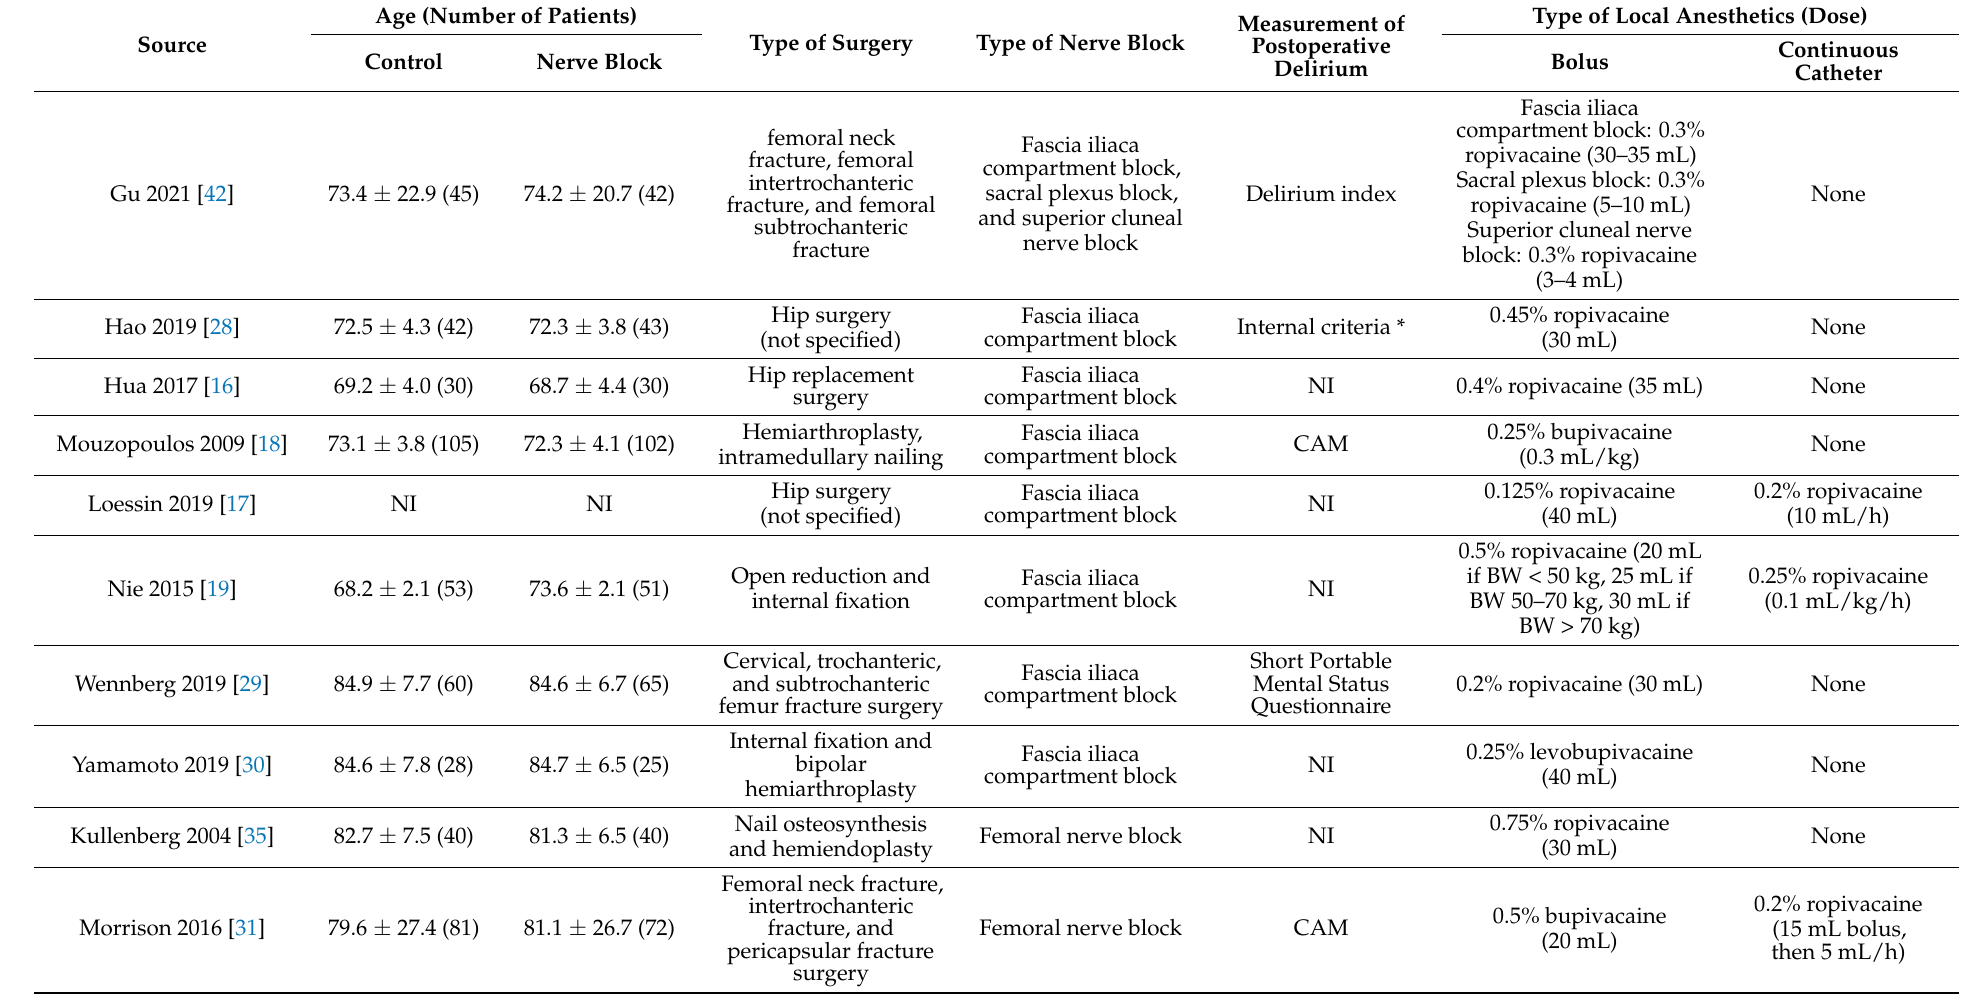
Table 1. Study design and characteristics of included